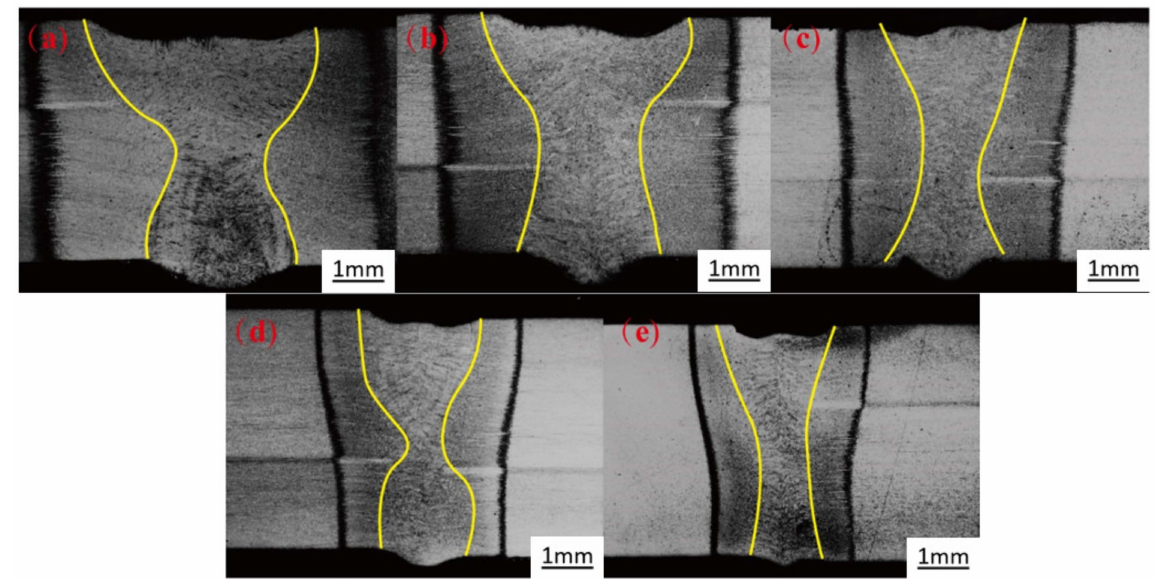
Figure 9. Macro morphology of the joint under different welding speeds: ( a ) 65 cm/min; ( b ) 75 cm/min; ( c ) 100 cm/min; ( d ) 125 cm/min; ( e ) 150